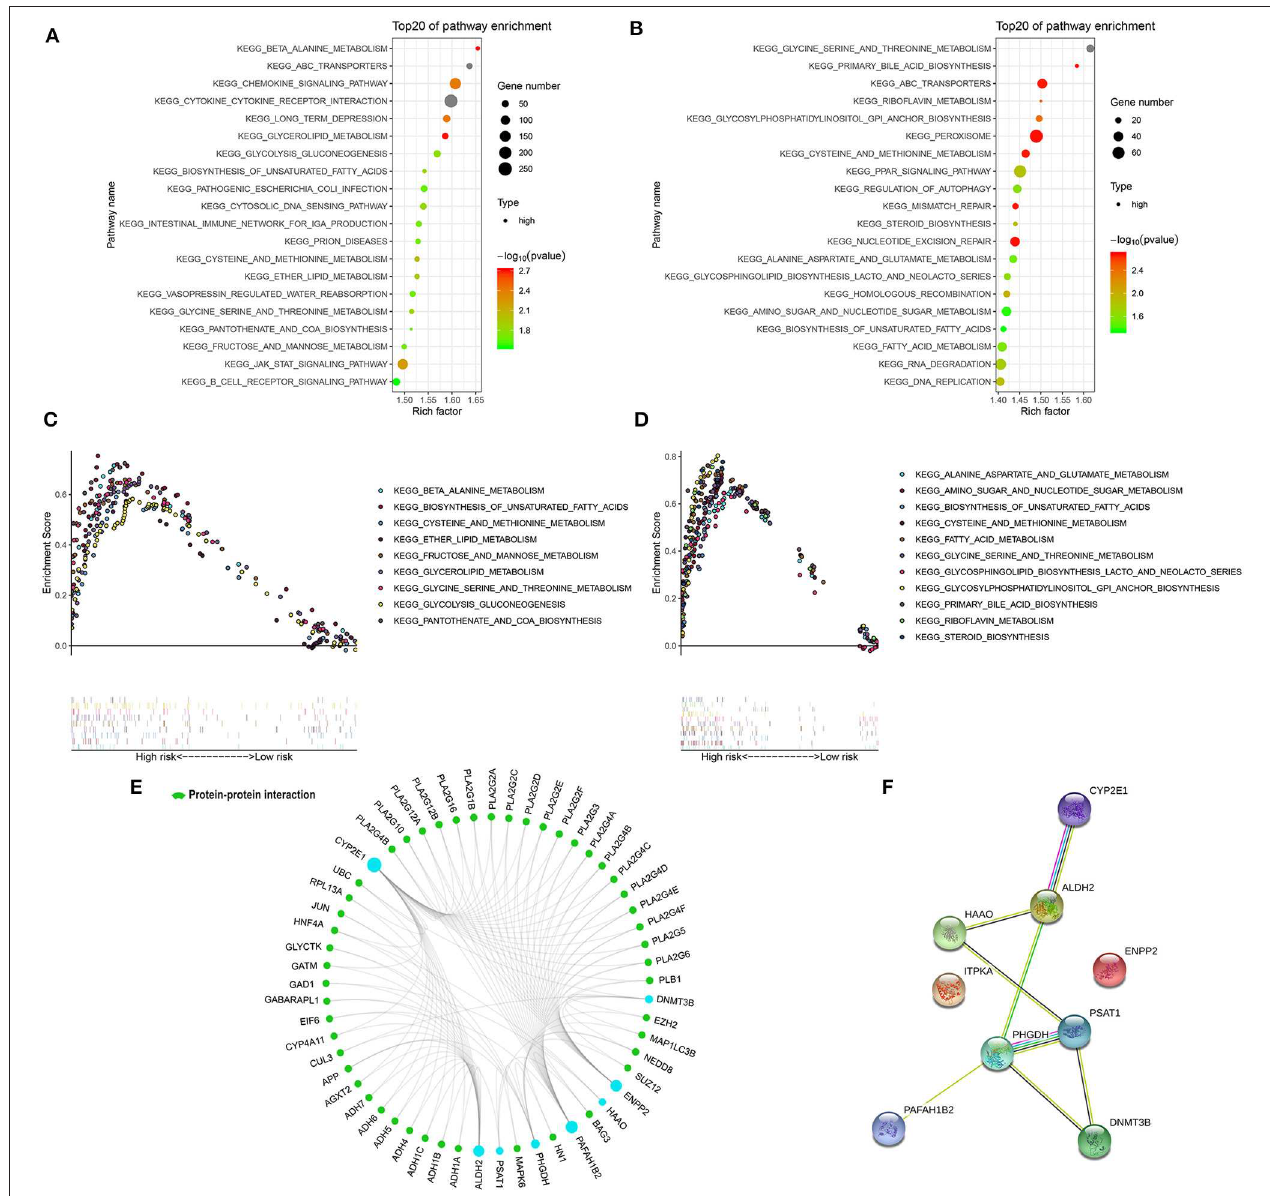
FIGURE 5 | Significantly enriched KEGG pathways in adult external cohort and pediatric external cohort based on GSEA. (A) Top 20 representative KEGG pathways in high-risk patients in adult external cohort ( p < 0 · 05). (B) Top 20 representative KEGG pathways in high-risk patients in pediatric external cohort ( p < 0 · 05). (C) Representative metabolic pathways in high-risk patients in adult external cohort. (D) Representative metabolic pathways in high-risk patients in pediatric external cohort. (E) The protein-protein interactions between the metabolic model related proteins and the other proteins. The model related proteins are shown in blue circles, and the size of which is determined by the number of interacting proteins. ITPKA has no known interactions with other proteins. (F) The interactions of 9 metabolic proteins.